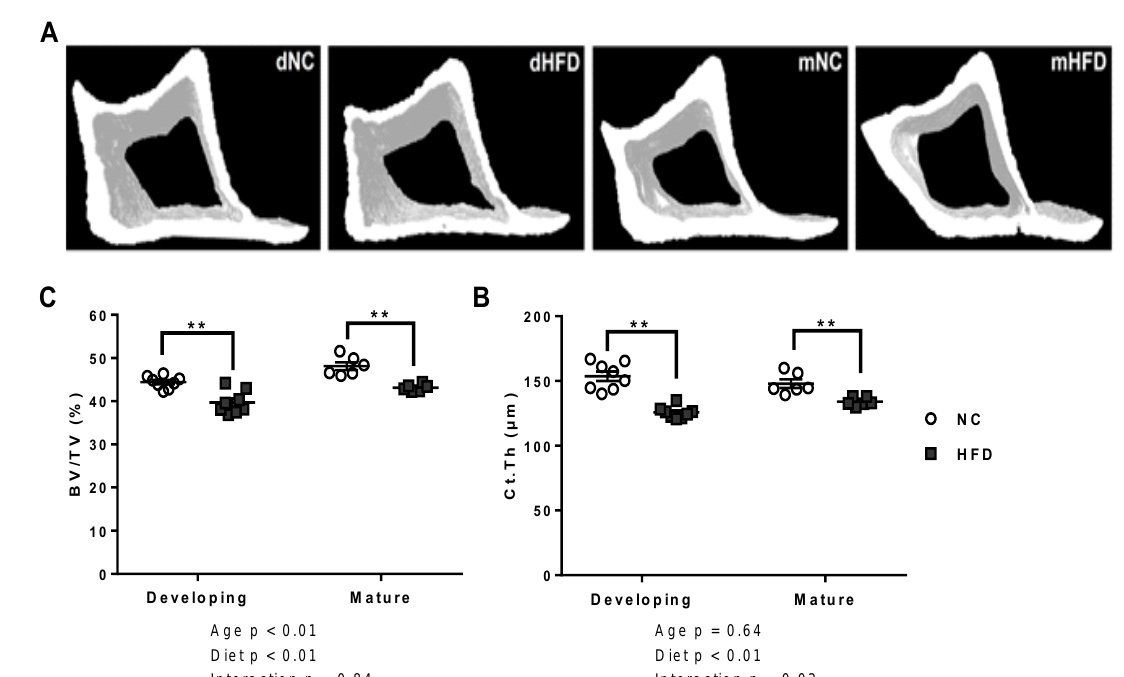
Figure 4. The high fat diet adversely affected tibial cortical bone outcomes in both developing and mature age groups. ( A ) Ex vivo µCT volumes of interest for tibial cortical bone analysis in developing normal chow (dNC), developing high fat diet (dHFD), mature normal chow (mNC) and mature high fat diet (mHFD) groups. ( B , C ) Bone volume to total volume ratio (BV/TV) and cortical thickness (Ct.Th) of developing and mature mice on normal chow (NC) and high fat diets (HFD). Results are presented as scatter plots with mean ± SEM ( n = 7 per group), ** represents p < 0.01, (2-way ANOVA followed by Bonferroni post-hoc analysis comparing diet within age groups).